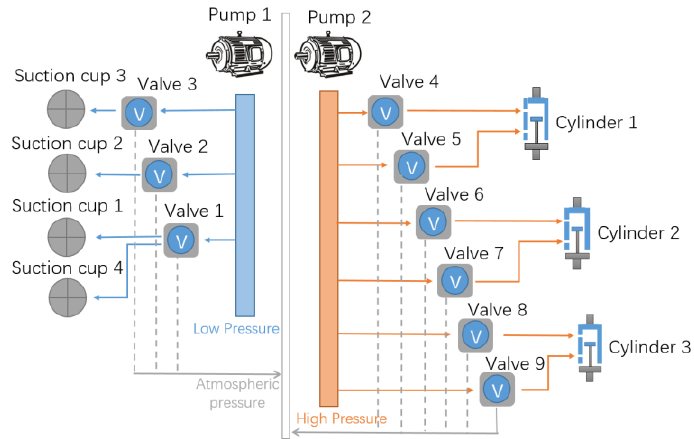
Figure 4. A diagram of the air circuit that consists of two pumps, nine valves, three sets of cylinders, and four pairs of suction cups: yellow represents the positive pressure generated by the first air pump, blue represents the negative pressure generated by the second air pump, gray represents the atmospheric pressure, and the direction of the arrow is the transmission direction of the air pressure signal. This figure does not cover the up and down motion of the feet controlled by motors.